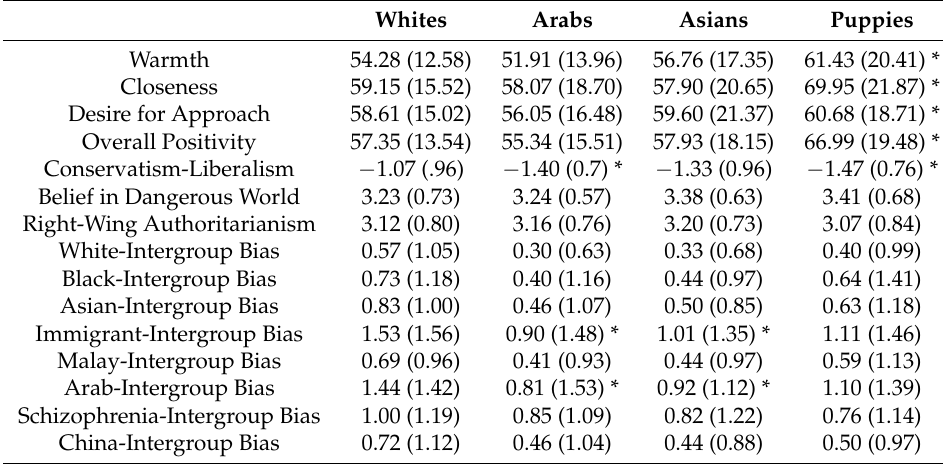
Table 2. Means and standard deviations (in parentheses) across the four face stimuli conditions (White infants, Arab infants, Asian infants, and puppies). Asterisk notation (*) indicates that the mean for a given facial stimuli condition (Arab infants, Asian infants, puppies) differs significantly from the White infant facial stimuli condition ( p <